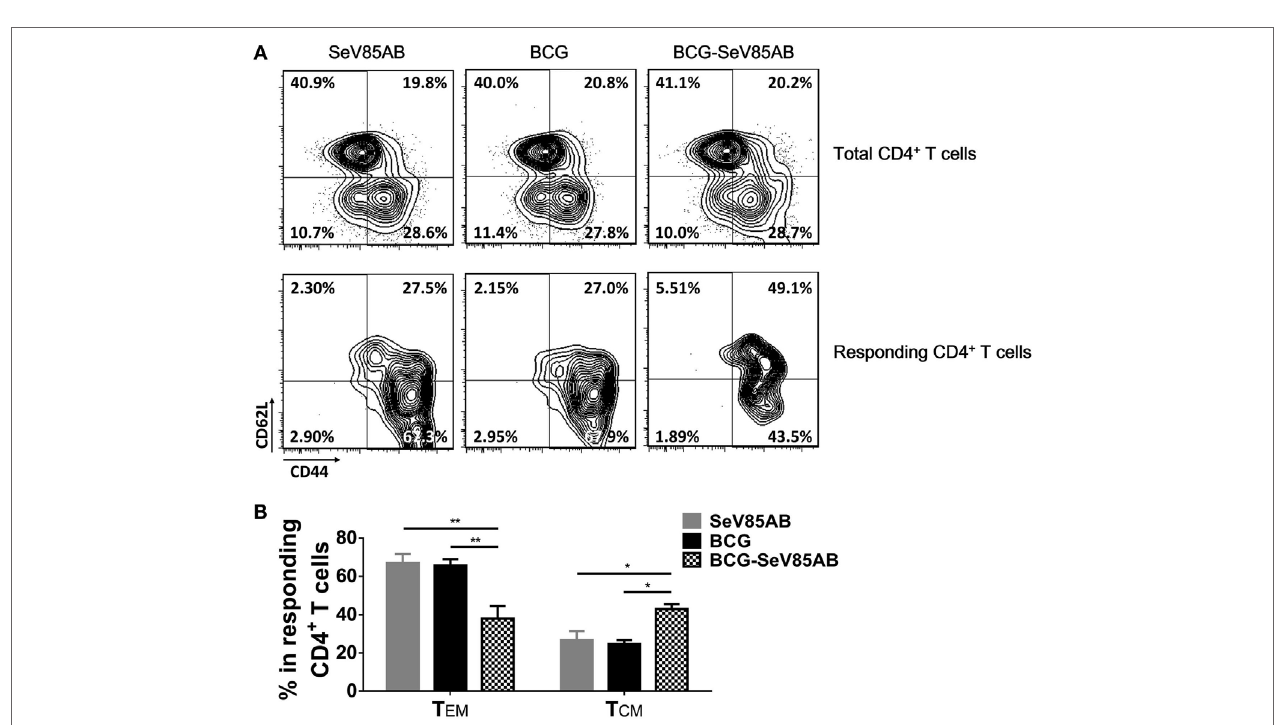
FigUre 8 | Memory phenotypes of recall T cell responses against Mycobacterium tuberculosis challenge. The memory phenotypes in total CD4 + T cells and Ag85AB-responding CD4 + T cells were assessed. The responding cells were defined as the cells that secreted at least one of the cytokines IFN- γ , IL-2, and TNF- α after Ag85AB peptide stimulation. Central memory T cells (T CM ) and effector memory T cells (T EM ) were defined as CD44 + CD62L + and CD44 + CD62L − , respectively. Representative flow cytometric plots (a) and summarized data (B) are shown. Data are representative of two independent experiments with three mice per group. * P < 0.05 and ** P < 0.01.